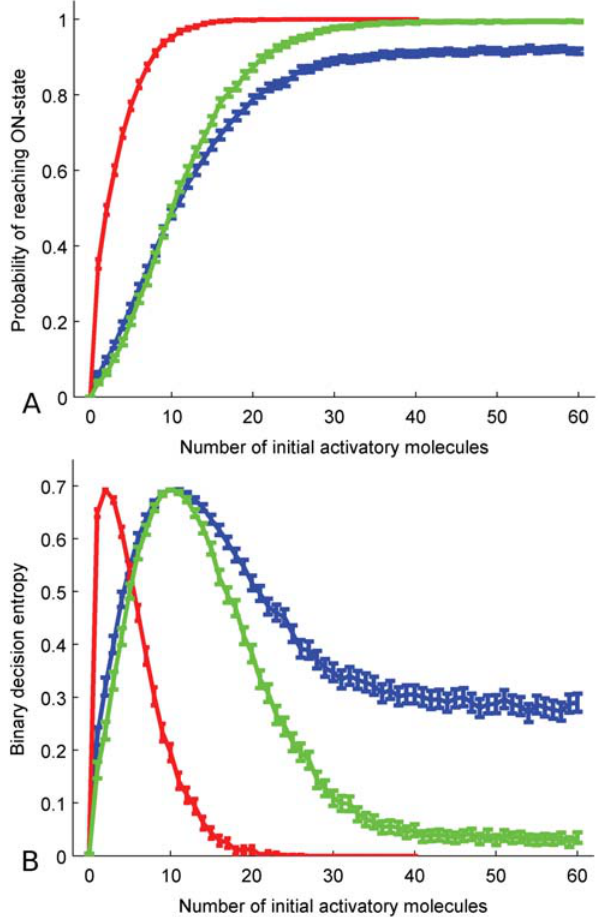
Figure 2. Statistical analysis of 10000 independent runs for each given number of regulatory input molecules. (A) Probability of reaching ON-state and (B) uncertainty of ON-OFF decision for one autoregulatory gene (blue), the two-gene circuit immediately after duplication (red) and with obligate heterodimerization (green). Shown are estimated values and 99% confidence intervals. Parameters are as in Table S2.